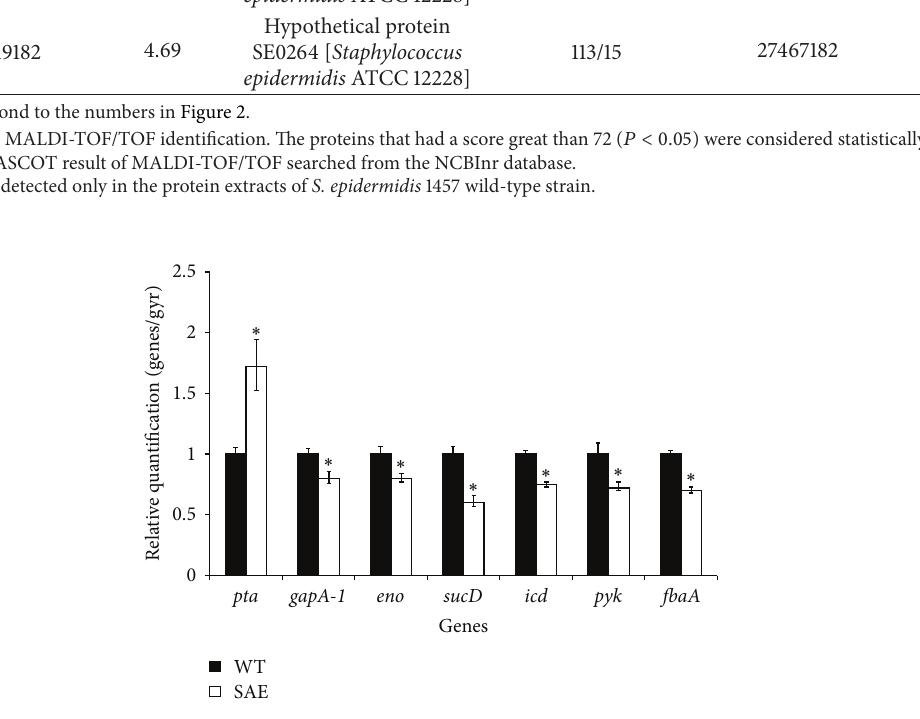
Figure 3: Quantitative transcript analysis of glucose metabolism-related gene transcript levels. Total RNA was extracted from SAE and WT grown in TSB medium at 37 ∘ C until the postexponential growth phase and the cDNA were then synthesized. The mRNA expression levels of glyceraldehyde 3-phosphate dehydrogenase (gapA-1), enolase (eno), succinyl-CoA synthase alpha subunit (sucD), isocitrate dehydrogenase (icd), pyruvate kinase (pyk), fructose-bisphosphate aldolase (fbaA), and phosphate acetyltransferase (pta) were determined using the beta- actin gene as an internal control. Data are shown as the mean ± S.D. Means with different letters are significantly different ( 𝑃 < 0.05